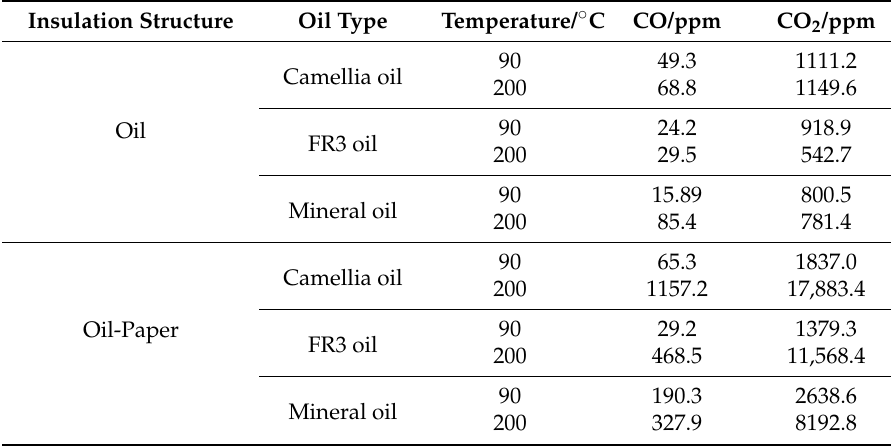
Table 4. CO and CO 2 content in oil under thermal faults below 300 ˝ C. Table 4. CO and CO2 content in oil under thermal faults below 300 °C.